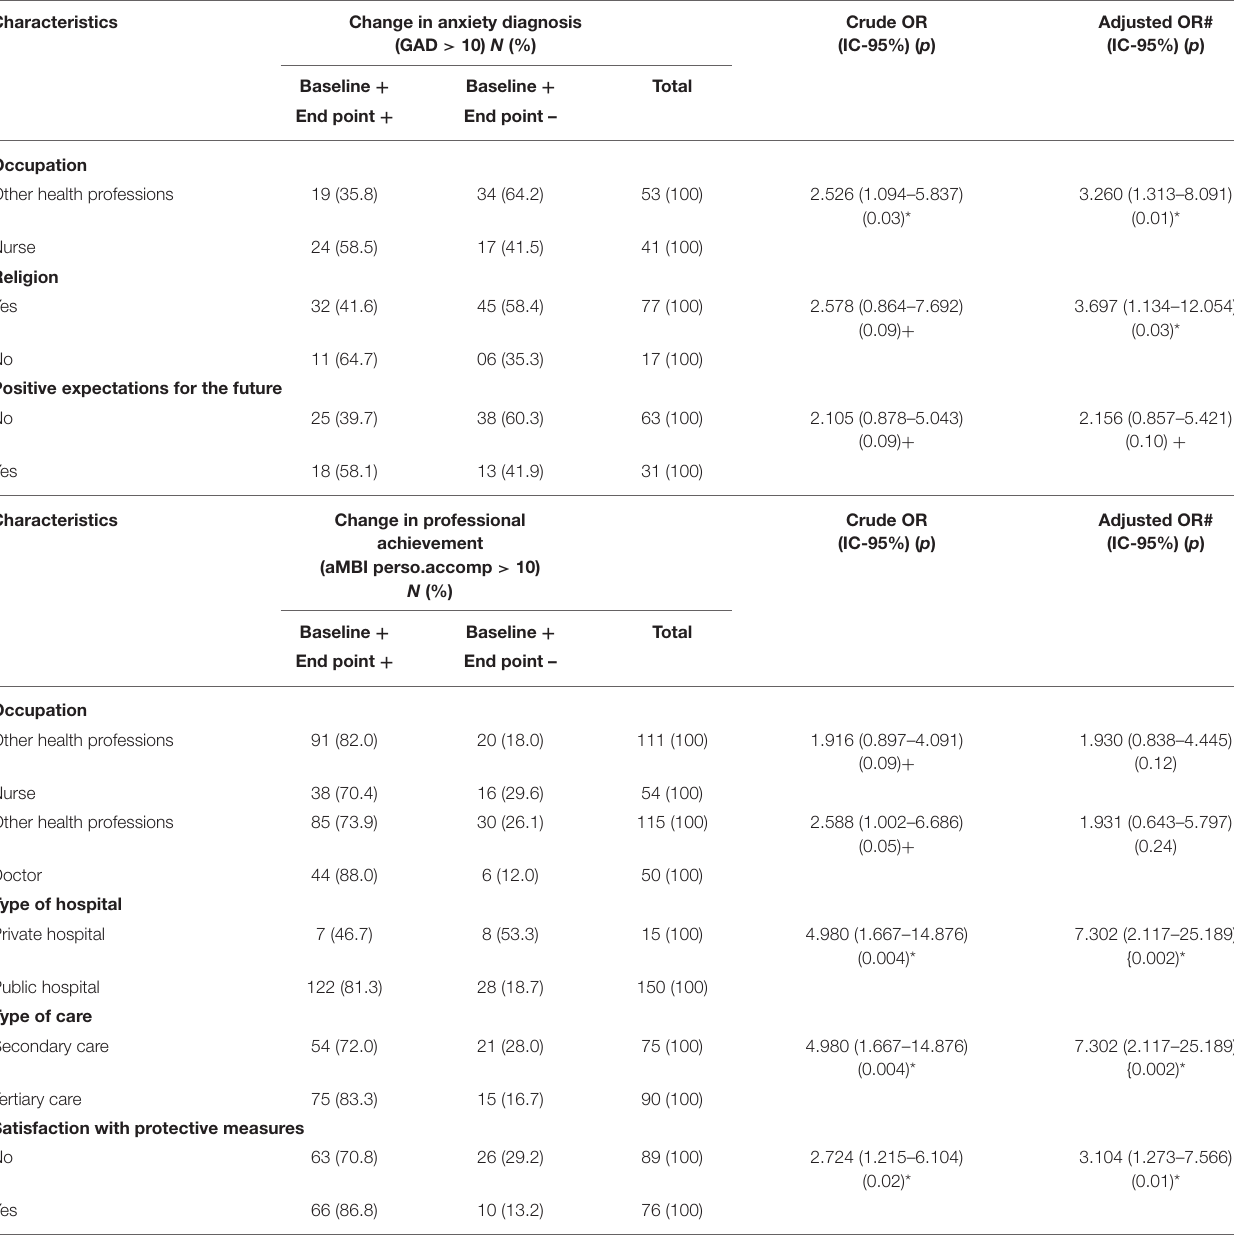
TABLE 3 | Characteristics at the baseline associated with a decreased number of participants with anxiety (GAD 7 > 10).